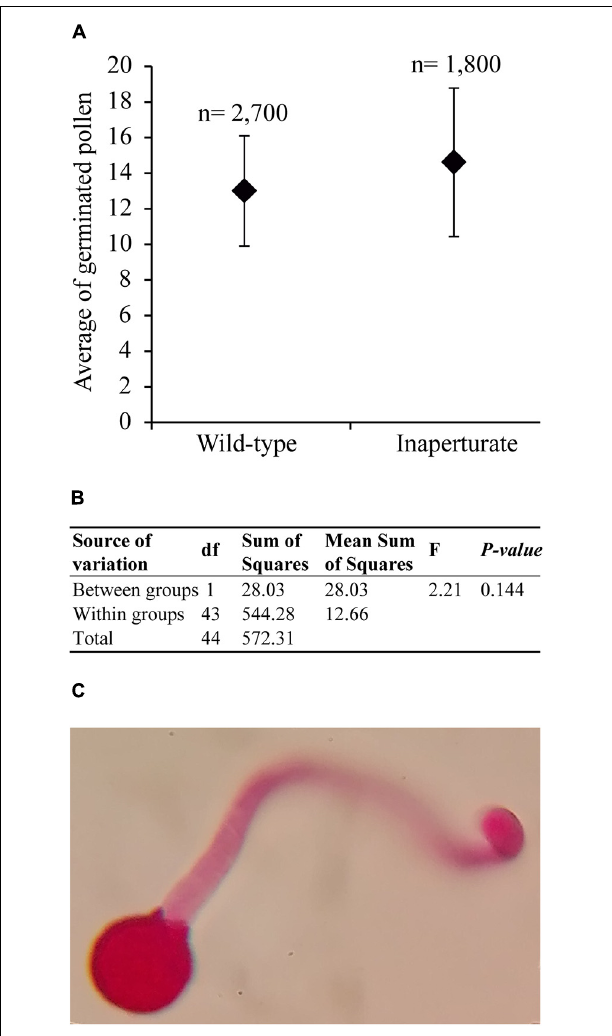
FIGURE 4 | Results of the Eschscholzia californica pollen germination test. (A) Scatter plot of the mean number of germinated pollen grains per each 100 pollen grains counted, for wild-type and inaperturate pollen. n, total number of pollen grains counted. (B) Summary table of the ANOVA analysis. (C) Optic microscope image of a germinated inaperturate pollen, stained with basic fuchsin, with the pollen tube emerging through the pollen wall.